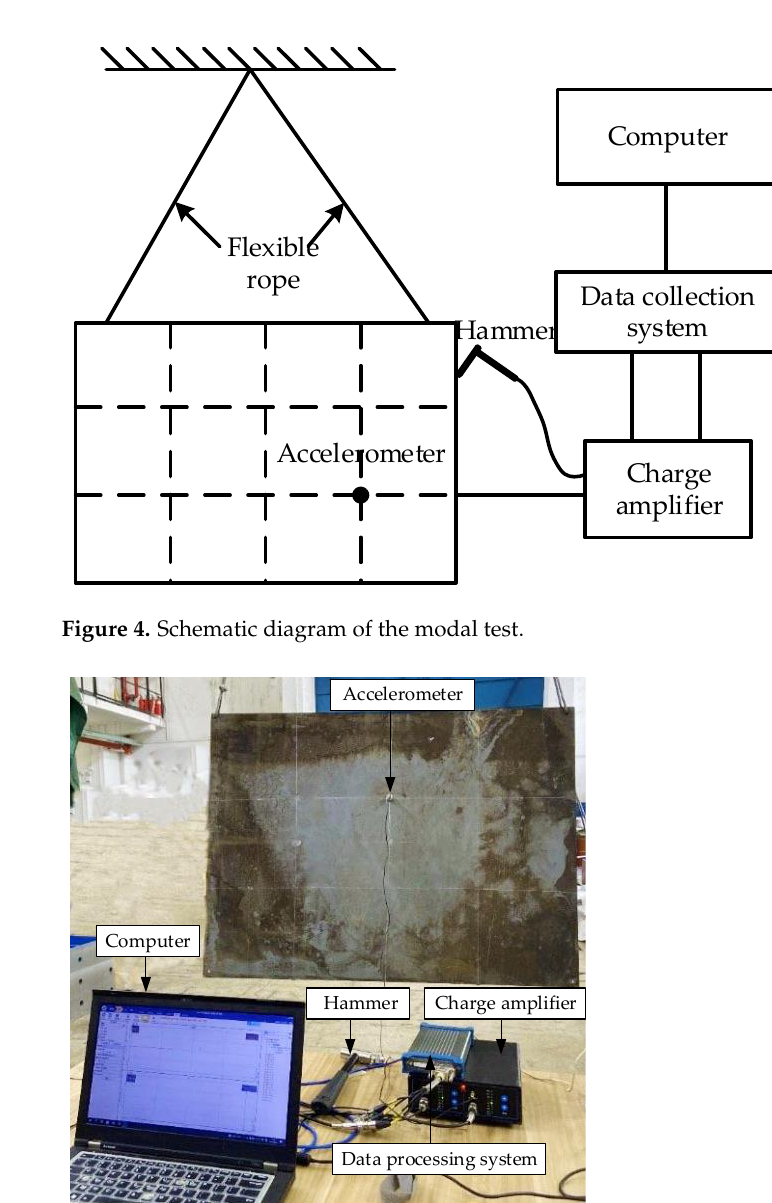
Figure 5. The actual experimental setup of the modal test.